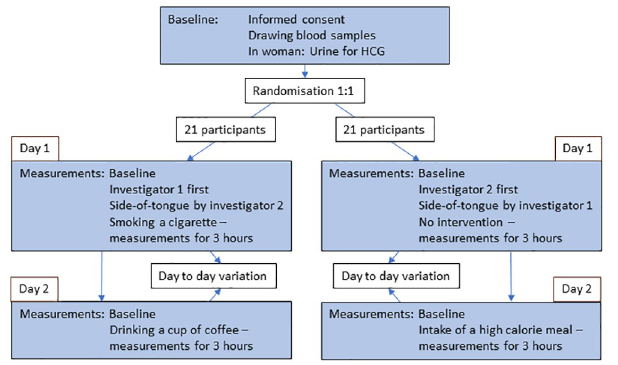
Fig 2. Study flow chart of the examination of glycocalyx in healthy